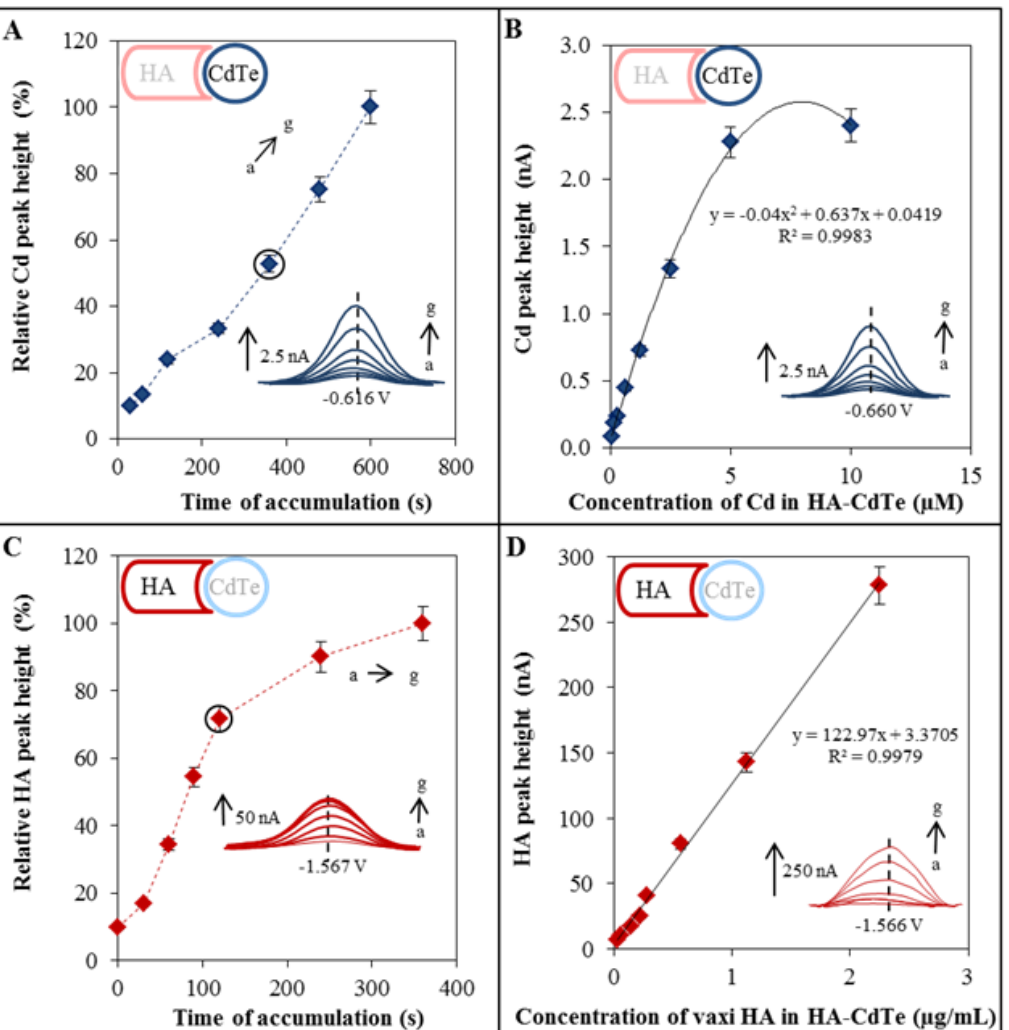
Figure 2. Electrochemical characterization of HA-QDs complex. Optimization and detection of the metal part of HA-CdTe complex . ( A ) Dependence of relative Cd peak height (related to the maximum value) on time of accumulation; ( B ) Dependence of Cd peak height on concentration of CdTe. For Cd determination DPASV was used under the following parameters: initial potential − 0.8 V; end potential − 0.5 V; deposition